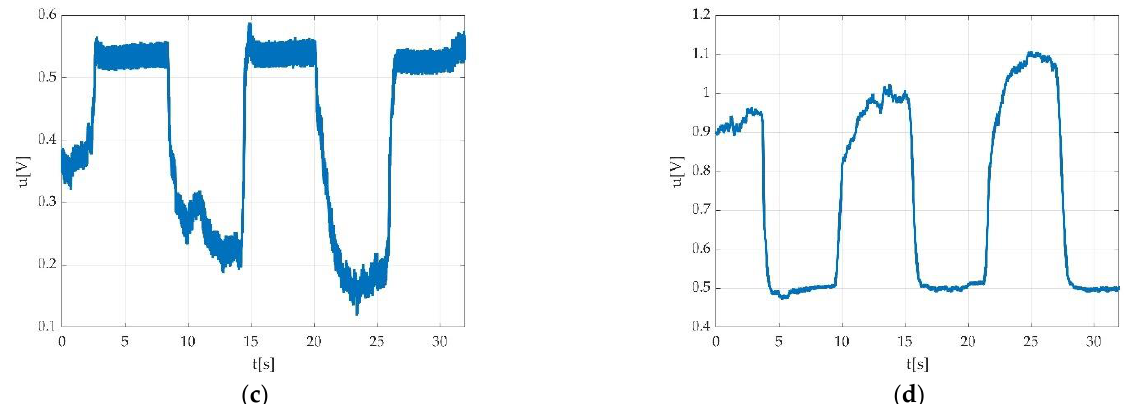
Figure 22. Example of not rejected time graphs: ( a ) contraction with the progressive increment of voltage value starting from first MVIC to the third MVIC; ( b ) muscle fatigue during the third MVIC during plantar flexion represented by decrement of voltage value; ( c ) progressive increment of volt- age value during three consecutive MVICs (dorsiflexion); ( d ) progressive increment of voltage value during three consecutive MVICs (plantar flexion).